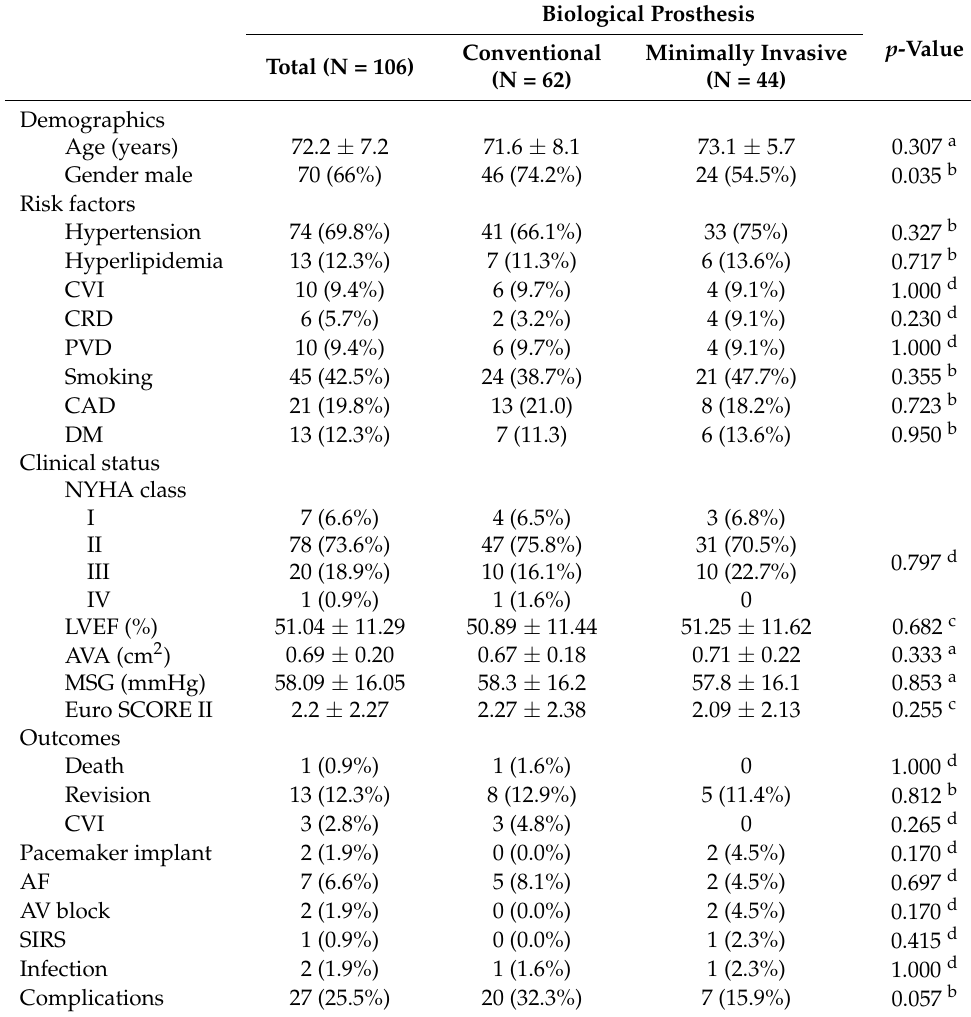
Table 3. Preoperative characteristics, clinical status, and the most important clinical outcomes of conventional and minimally invasive AVR patients with biological prostheses. Biological Prosthesis p -Value Total (N =